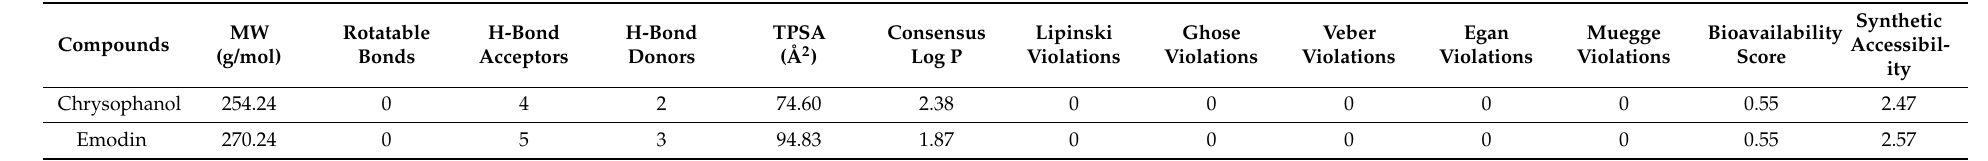
Table 7. Drug-likeness prediction from SwissADME server (MW = Molecular Weight, TPSA = total polar surface area, Consensus Log P = average of all predicted Log